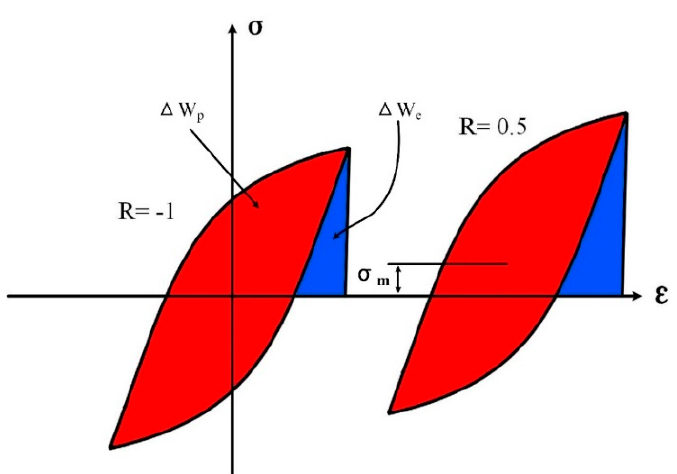
Figure 2. Schematic of hysteretic loops under same strain amplitude and different strain ratios of 0 and 0.5.